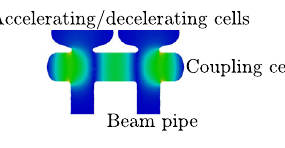
FIG. 11. A mode confined to the coupling cell which is